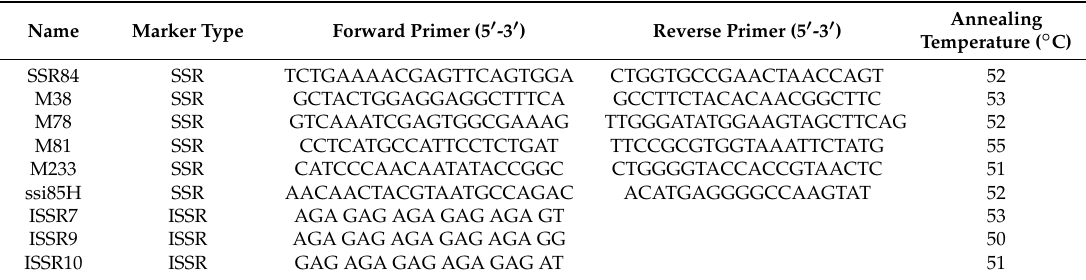
Table 2. Molecular markers mapped at or close to the zt-1 locus.